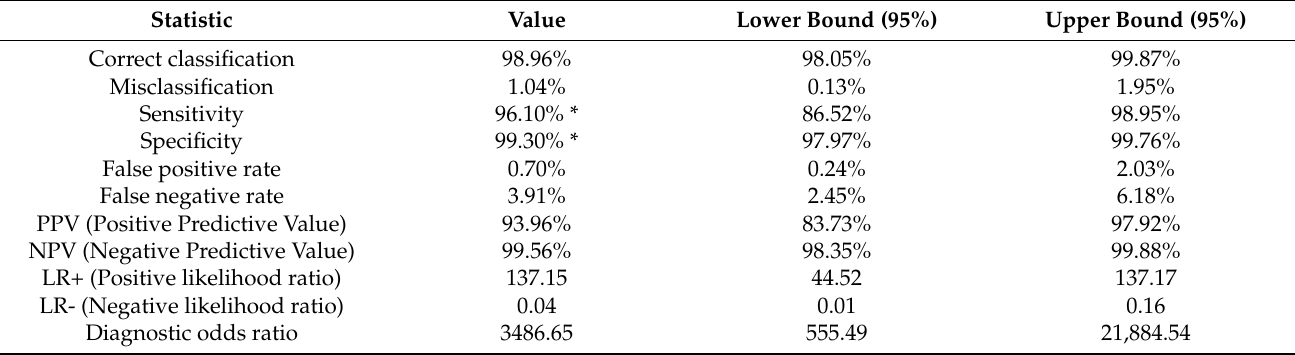
Table 2. Properties of RBT.